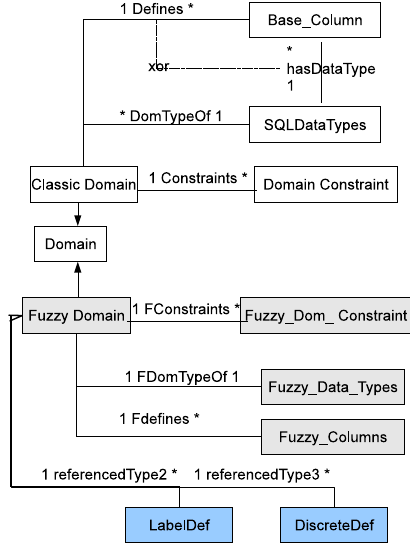
Fig. 1. Fuzzy Catalog Ontology Domain.